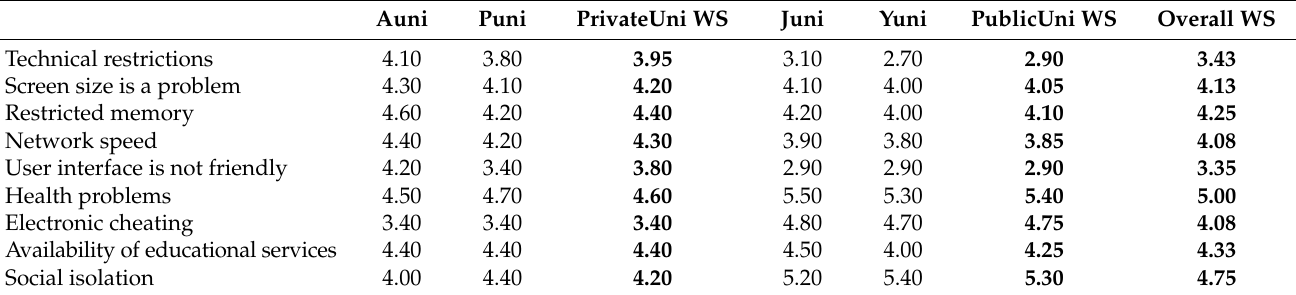
Table 6. Students’ evaluation of the disadvantages of adopting mobile learning in Jordanian higher